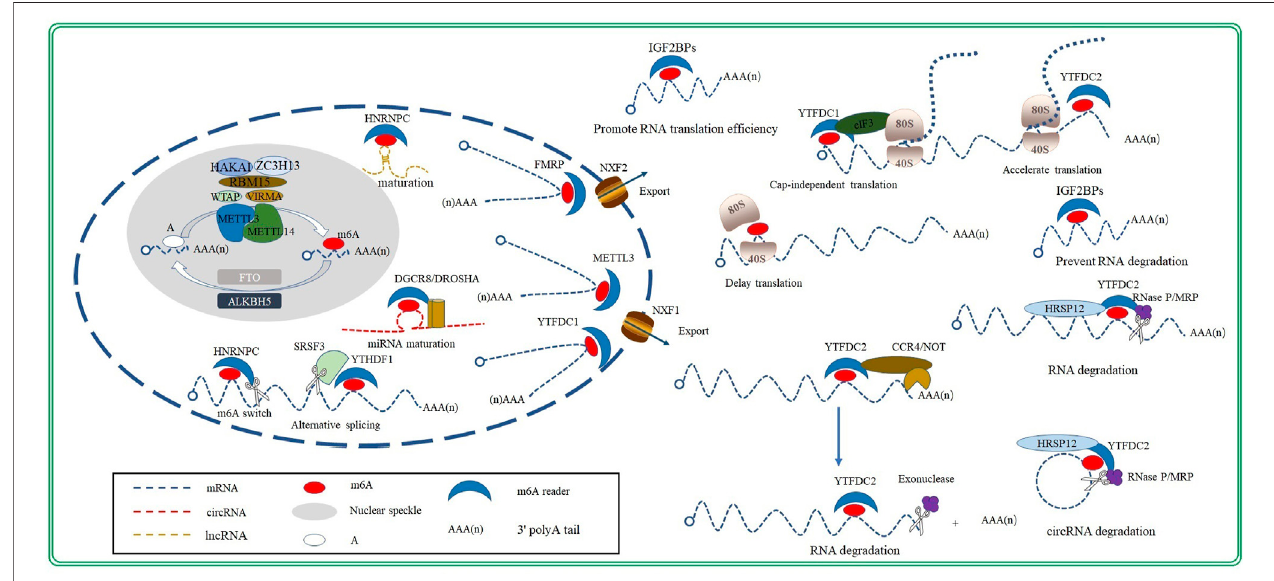
FIGURE 1 | Regulation and biological function of m6A modi fi